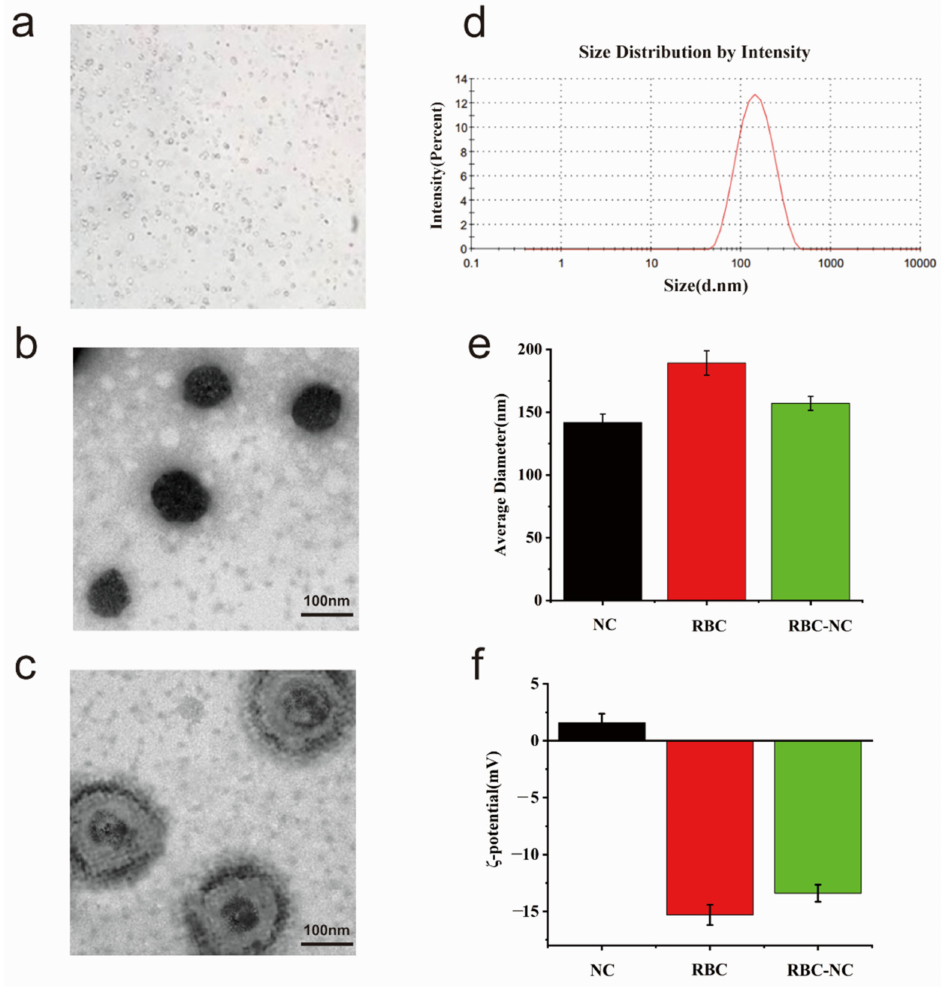
Figure 2. ( a ) The morphology of RBC-NC(DOX) observed through the microscope. ( b ) Transmission electron microscopy (TEM) visualization of NC(DOX) and ( c ) RBC-NC(DOX) with phosphotungstic acid staining (scale bar = 100 nm). ( d ) Particle size distribution of RBC-NC(DOX). ( e ) The changes of particle size before and after RBC package. ( f ) The changes of potential before and after RBC wrapping. Error bars represent standard deviations (n =